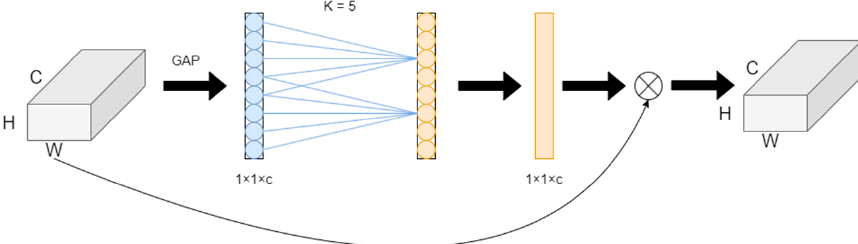
Figure 7. ECA-Net network architecture: the global pooling layer (GAP) obtains aggregated features and ECA generates channel weights by performing one-dimensional convolution of size k , where the value of k was determined by the channel dimension C .